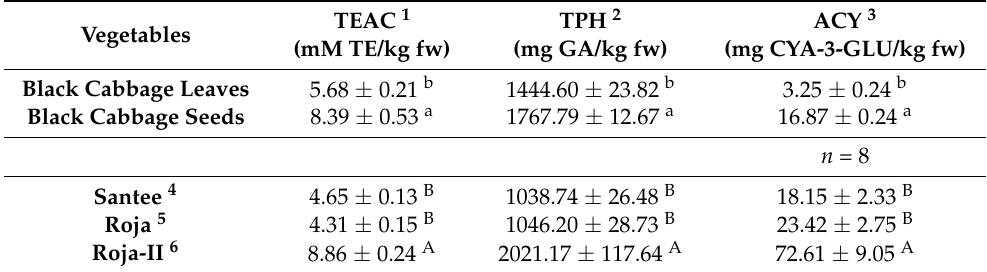
Table 3. Average values of total antioxidant capacity, phenolics and anthocyanins content of the different vegetables